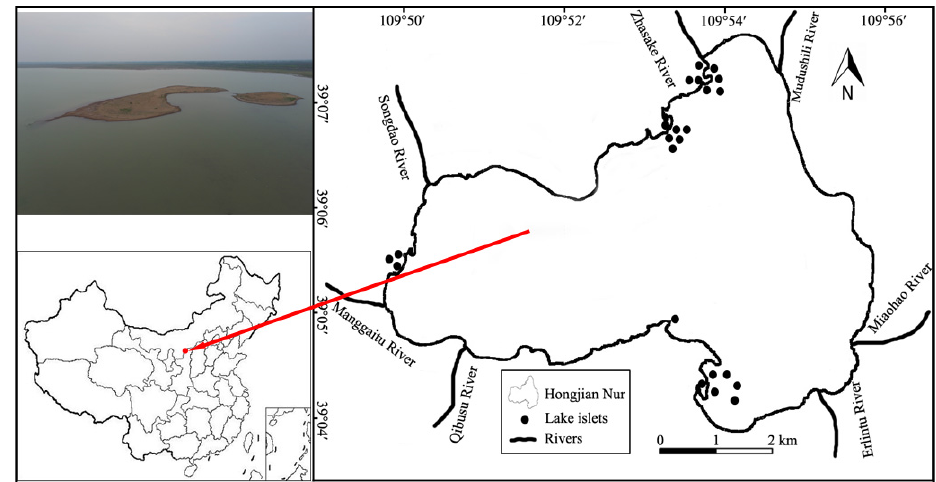
Figure 1. Map of the Hongjian Nur shows the breeding islets’ distribution, where relict gulls have bred at least once between 2001–2020. Upper left is aerial photo of islets;the dots show the location of the different islets within the breeding areas, and the red dot shows the location of Hongjian Nur, Shaanxi, China. (Schematic drawing based on GPS data of 2014.)